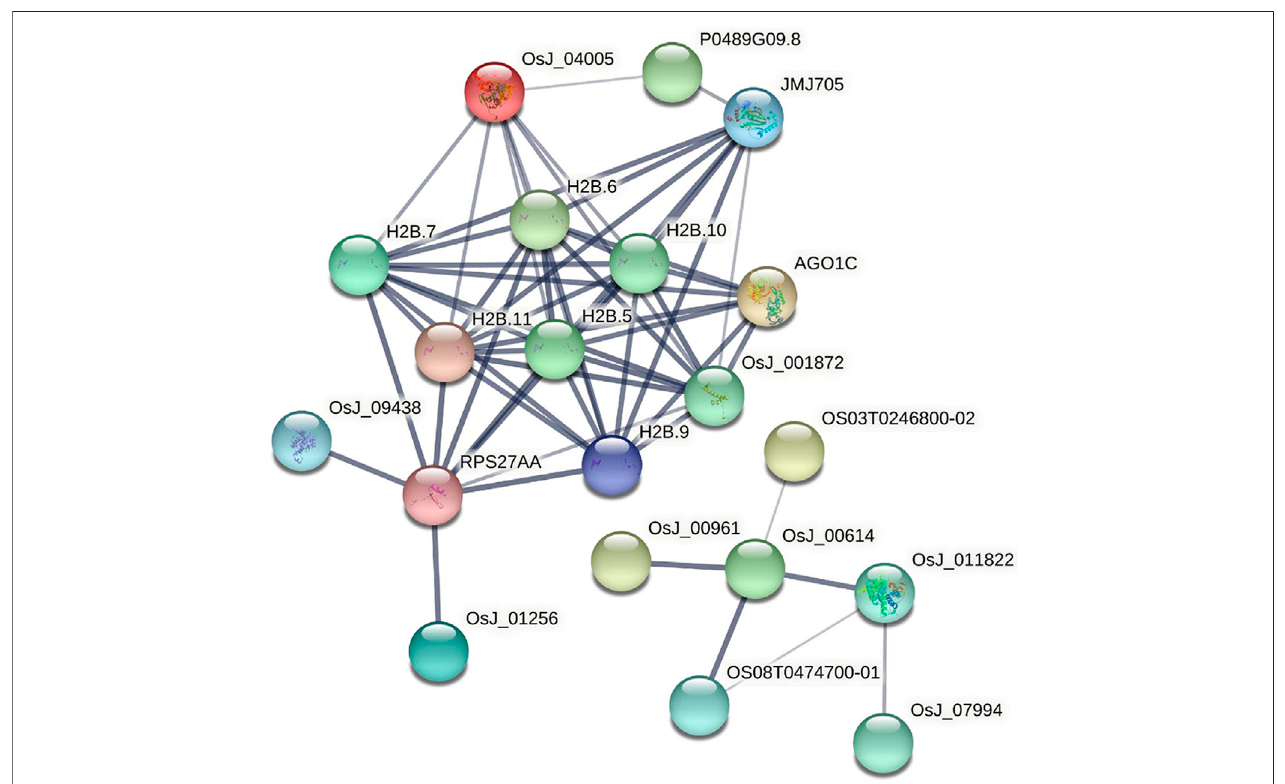
FIGURE 10 | PPI network diagram of rice core